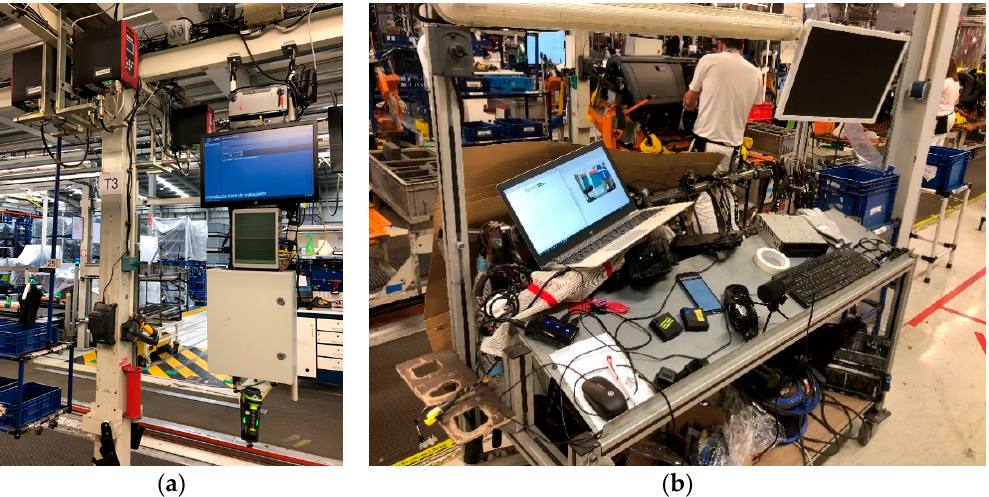
Figure 1. Assembly line segment ( a ) and experimental measuring and testing workstation ( b